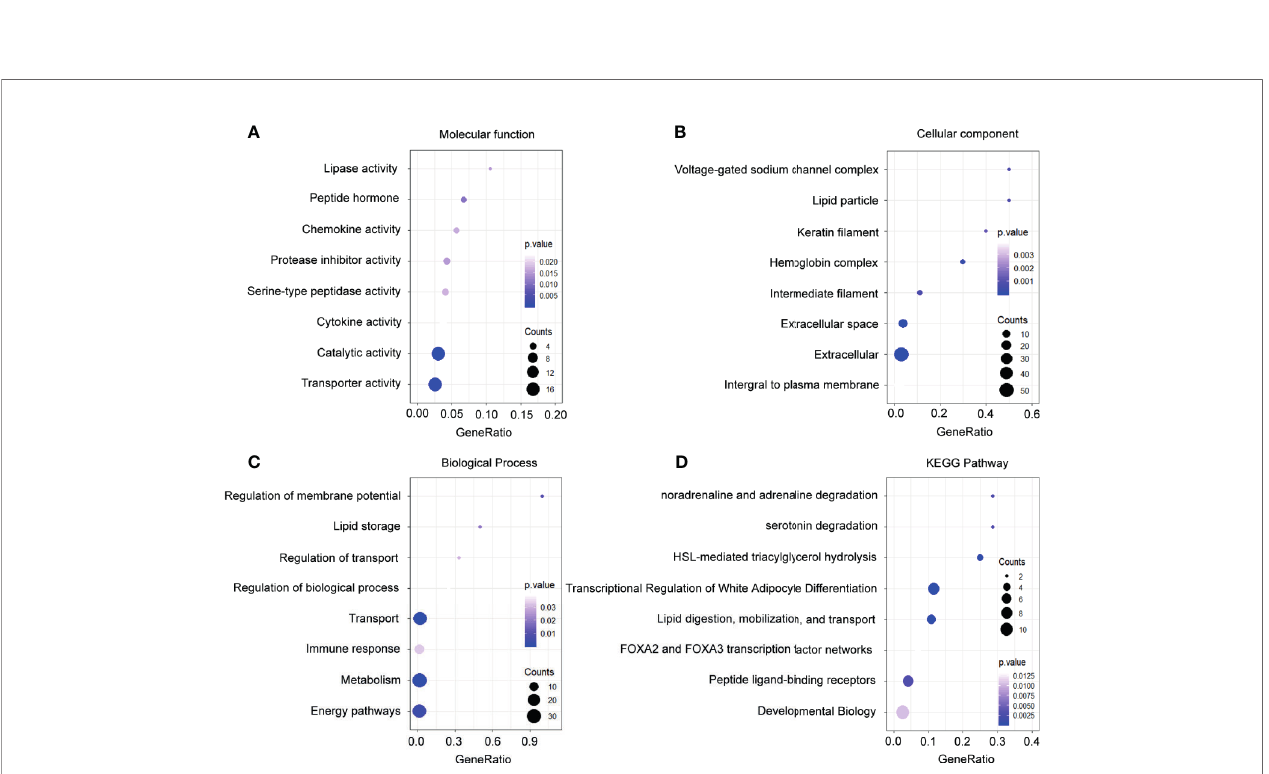
FIGURE 4 | Functional enrichment analysis of the downregulated genes. (A) Enrichment of molecular function. (B) Enrichment of cellular component. (C) Enrichment of biological process. (D) Enrichment of Kyoto Encyclopedia of Genes and